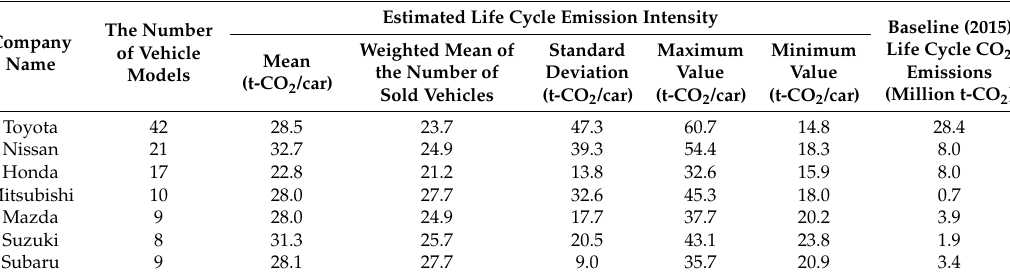
Table 1. Lifecycle CO 2 intensities and life cycle CO 2 emissions in